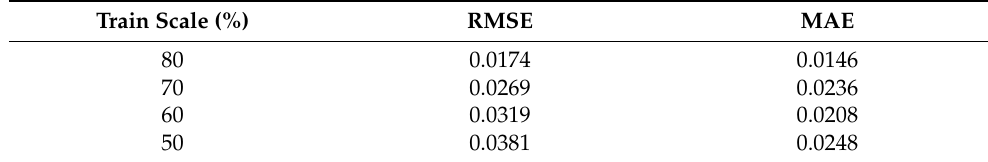
Table 6. Comparison of prediction results of different training scale